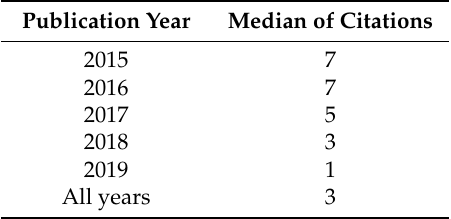
Table 2. Median number of citations per year, for all articles ( n =